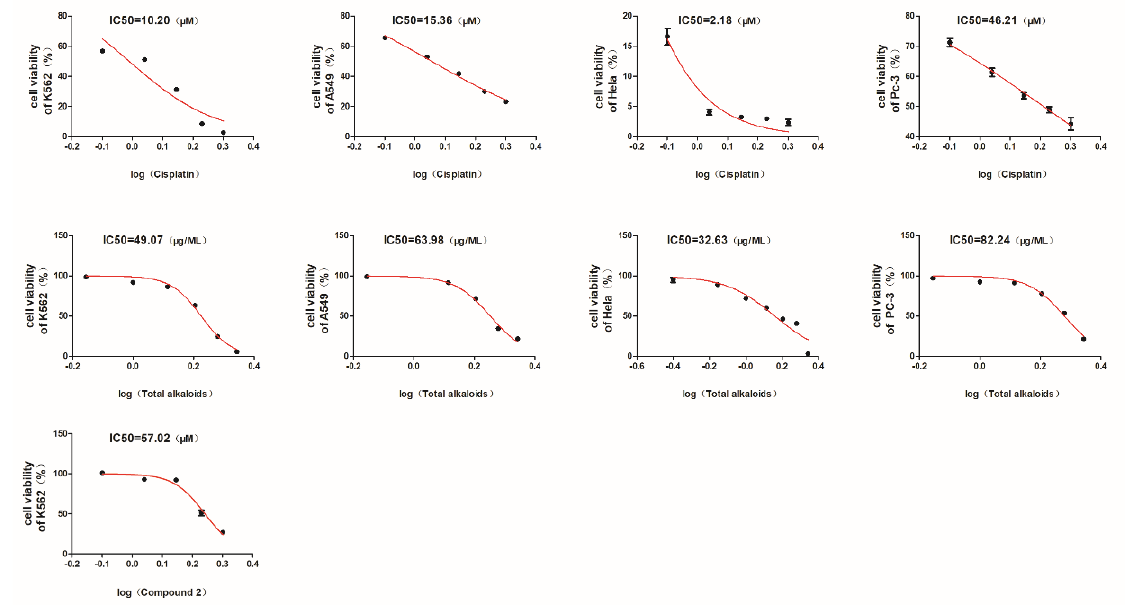
Figure 7. The IC 50 values of the total alkaloids, compound 2 , and positive control drug cisplatin.